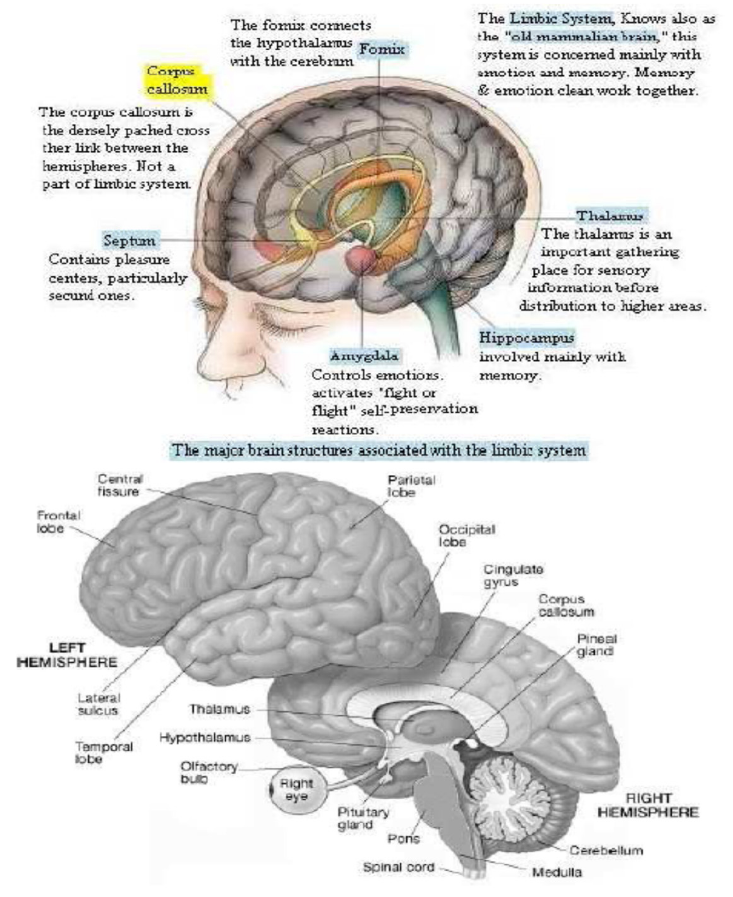
Figure 4. Brain structural related to the Limbic System, adopted from [22].